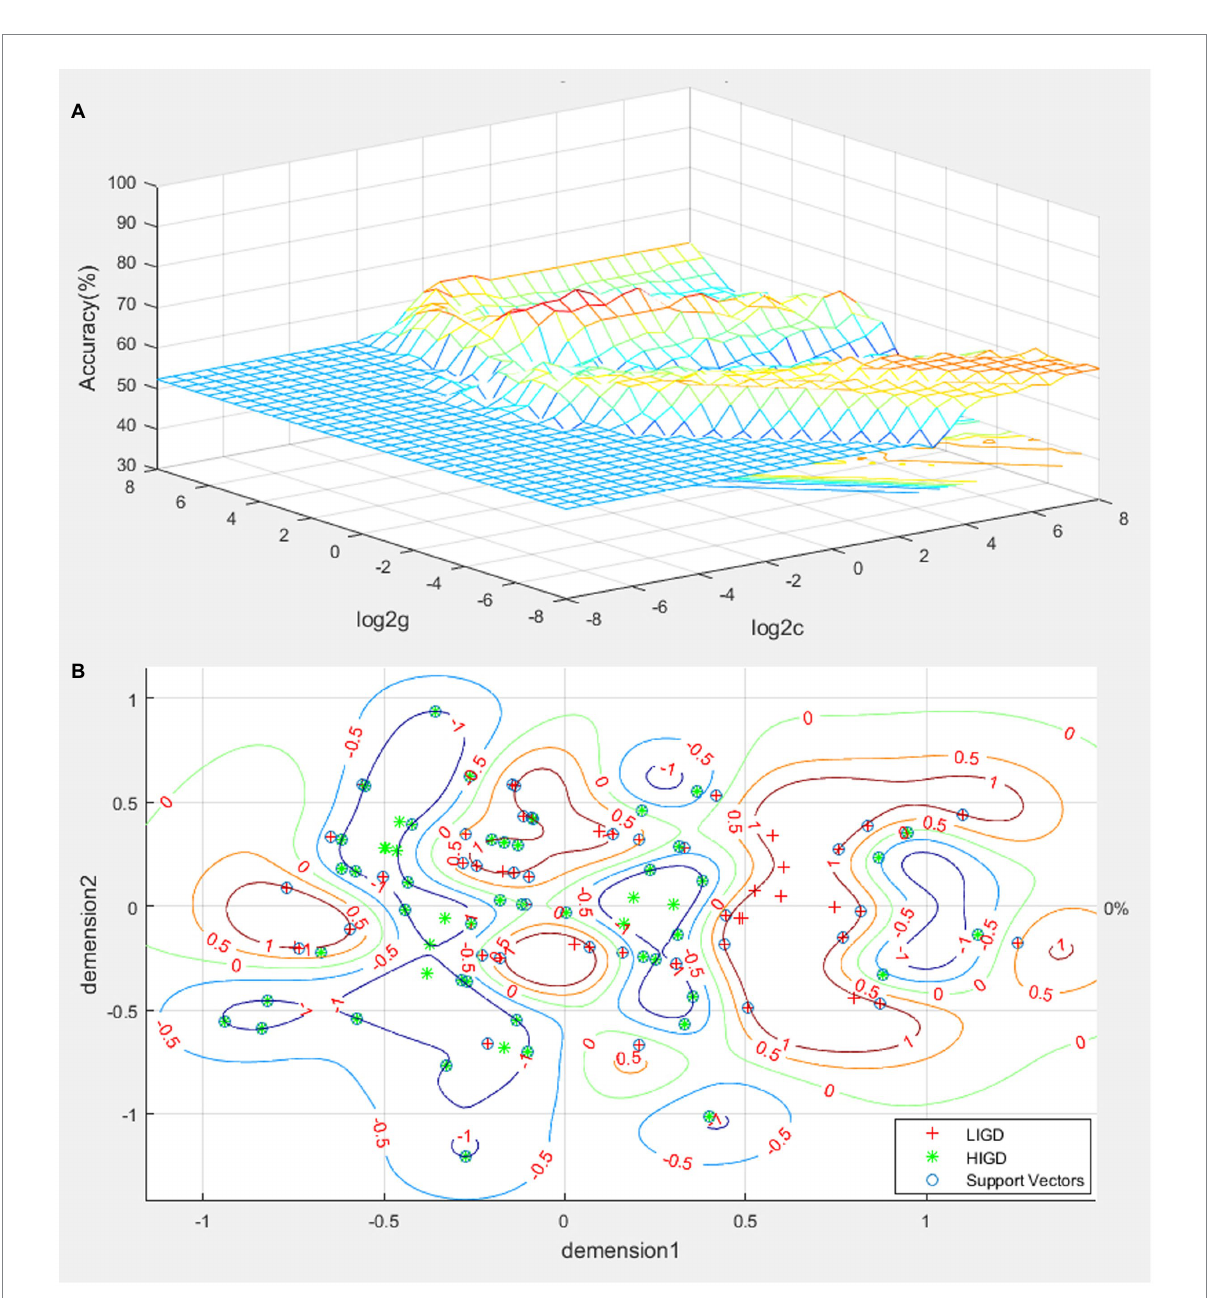
FIGURE 3 SVM of the combination of the correct rate of anti-saccade task and emotion regulation score. (A) , parameter optimization; (B) , visualization of classification.